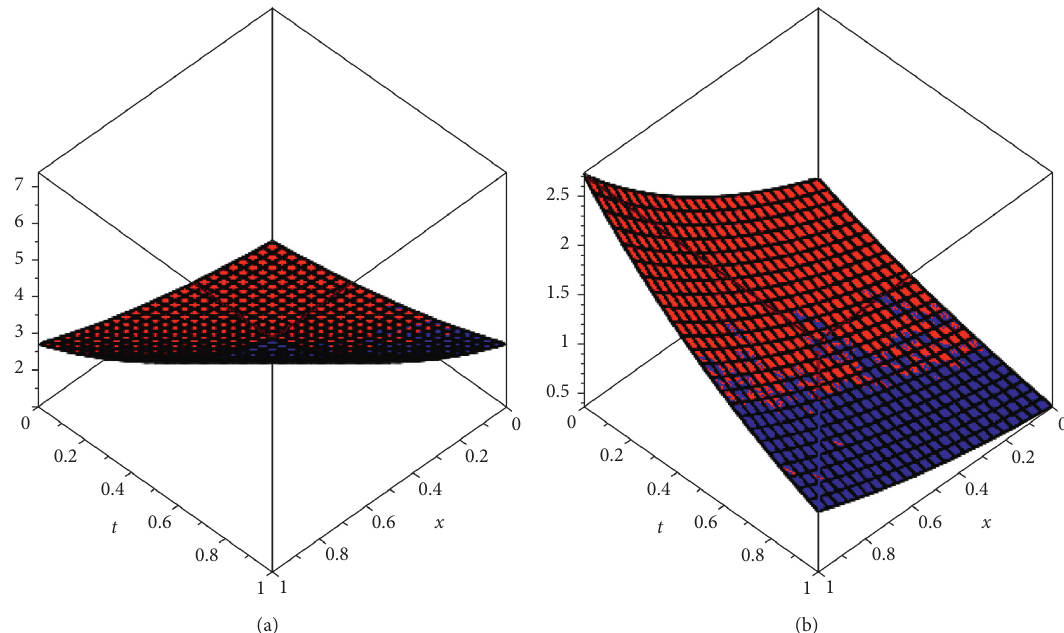
Figure 7: Comparison of the exact solution (blue) and the approximate solutions (red) of Example 7. (a) The solution of w solution of v n ( x, t )